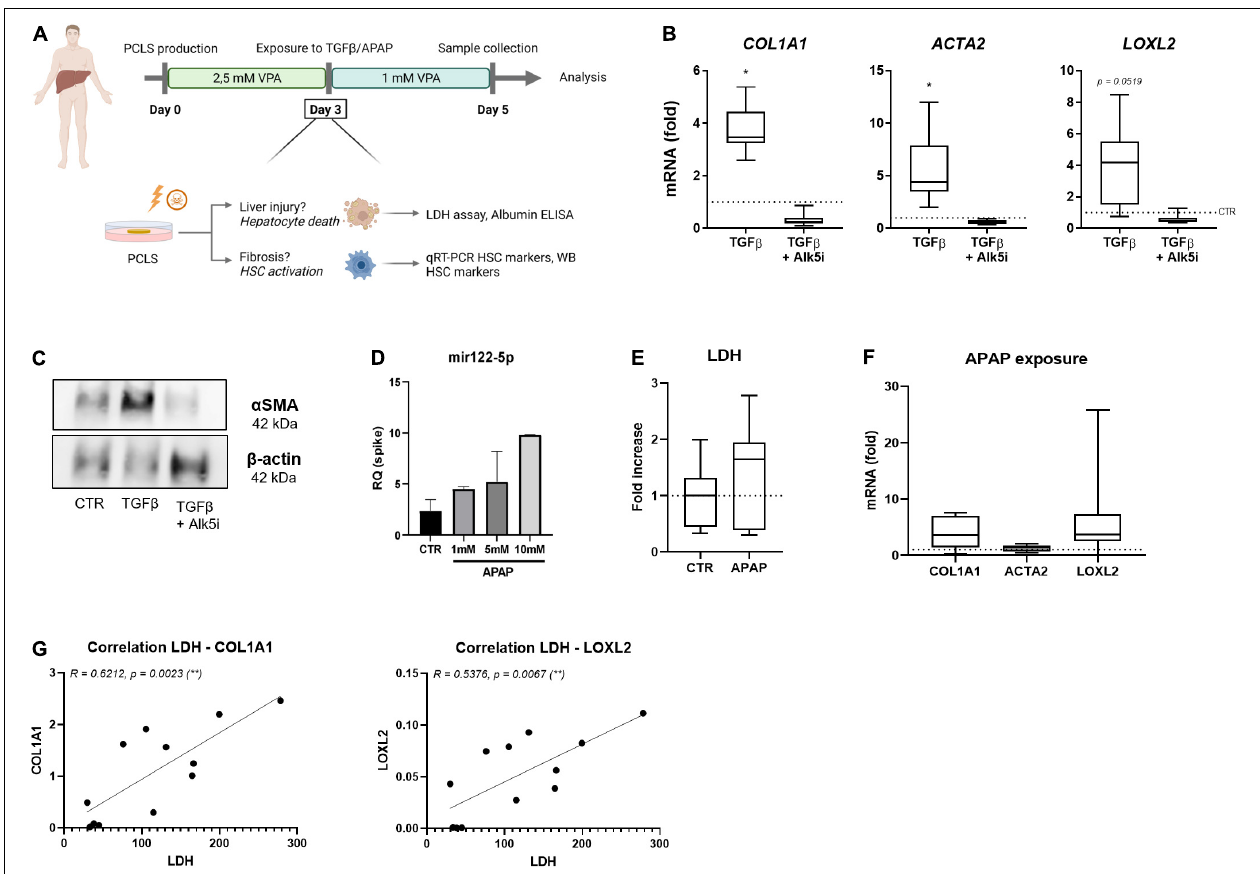
FIGURE 4 | Human PCLS V cultures allow HSC activation modeling. (A) Human PCLS were cultured for 3 days in the presence of 2.5 mM VPA. On day 3 of culture, PCLS were exposed to 10 ng/ml TGF β or 1 mM APAP, while VPA concentration was reduced to 1 mM for the last 48 h. On day 5 of culture, PCLS were analyzed. (B) mRNA levels of HSC activation markers were analyzed by qRT-PCR after 48 h exposure to TGF β in the absence or presence of its inhibitor Alk5i ( n = 9). (C) Western blot analysis of α SMA protein expression in the human PCLSV culture is increased upon TGF β exposure. (D) miRNA122-5p expression in culture medium of human PCLSV exposed to different concentrations of APAP ( n = 3). (E) LDH levels in culture medium of human PCLSV exposed to 1 mM APAP for 48 h ( n = 7). (F) mRNA expression of HSC activation markers COL1A1 , ACTA2 and LOXL2 in PCLS V exposed to 1 mM APAP for 48 h ( n = 7). (G) The correlation of LDH leakage and HSC activation markers COL1A1 and LOXL2 of untreated human PCLS V on day 5 of culture. * p ≤ 0.05, ** p ≤